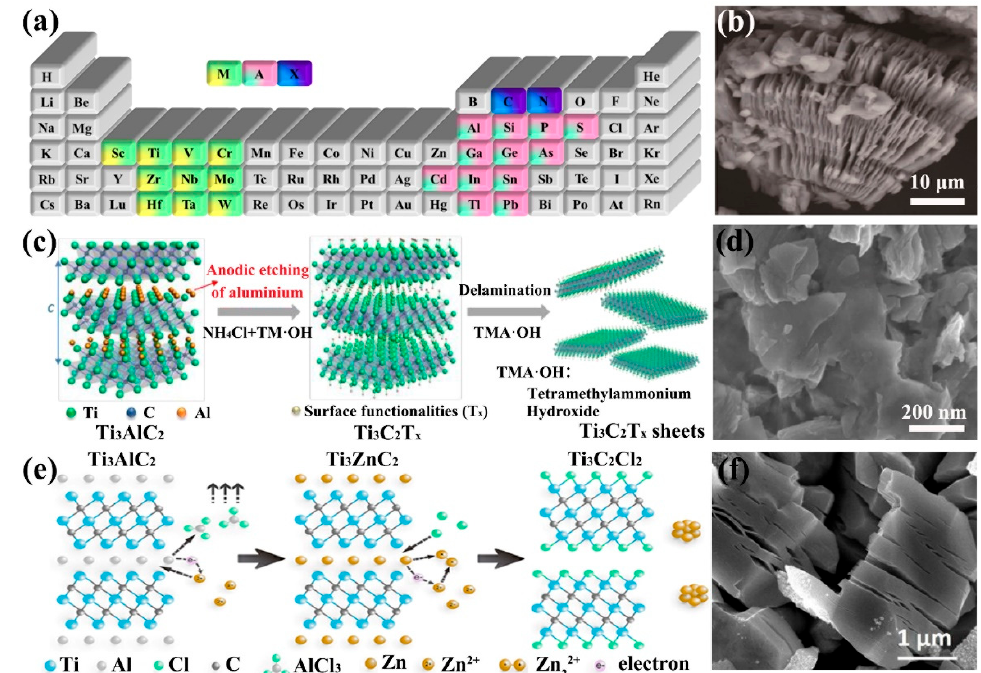
Figure 2. ( a ) Elements represented by MAX respectively. ( b ) SEM image of Ti 3 C 2 synthesized by